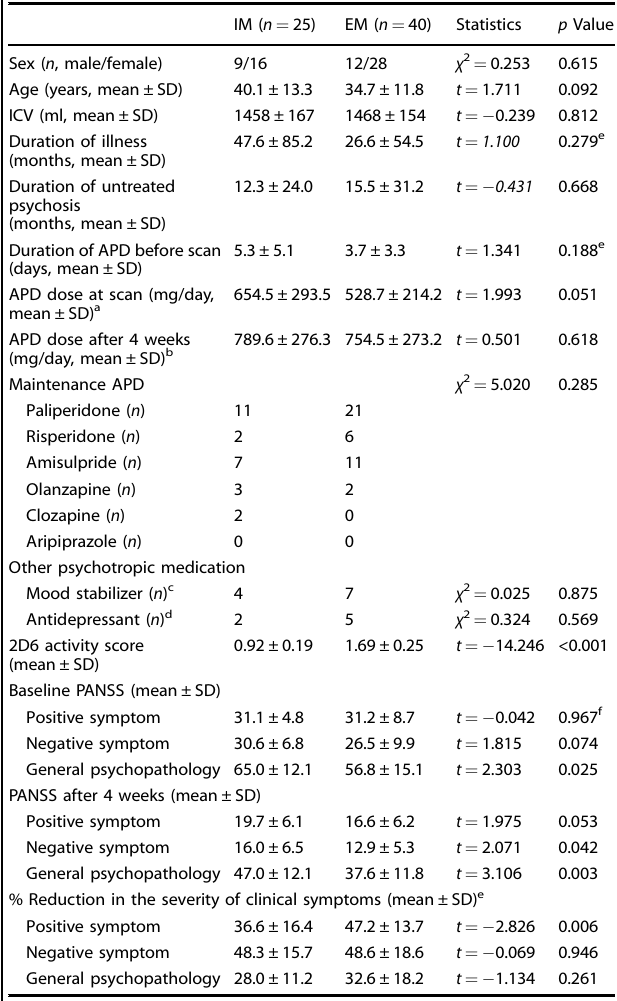
Table 2. Sociodemographic and clinical characteristics of the 4-week follow-up